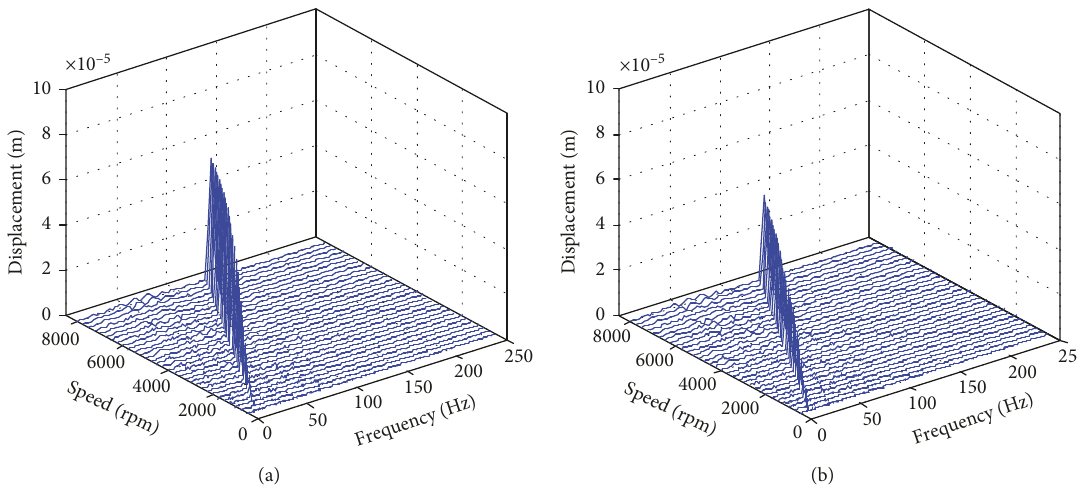
Figure 12: Three-dimensional frequency spectrums of the displacement (a) without unbalance control and (b) with unbalance control.